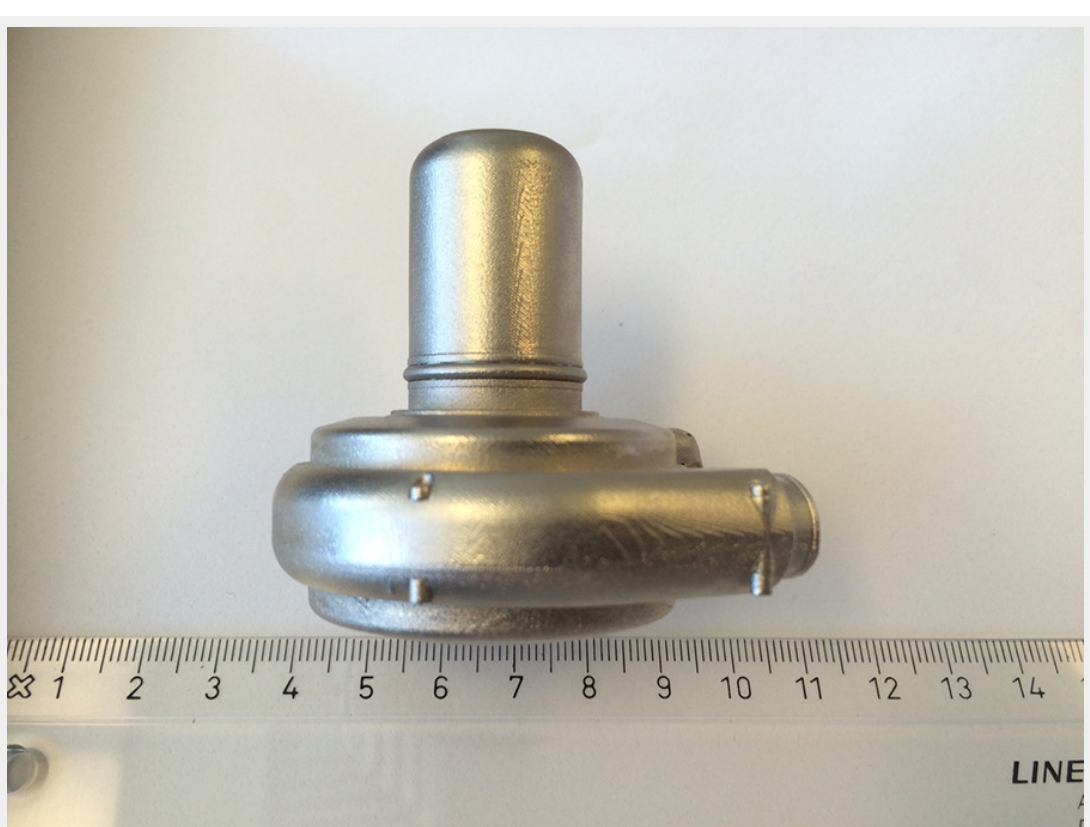
The HeartWare (HeartWare Corporation, Framingham, Massachussetts, USA) device (HVAD) is a centrifugal, continuous flow pump with a wide-blade impeller that is magnetically and hydrodynamically suspended. HVAD pump flow is preload dependent and afterload sensitive with a speed range of 1800–4000 RPM and a maximum outflow of 10 l/min. HVAD weight is 160 g and it fits in a